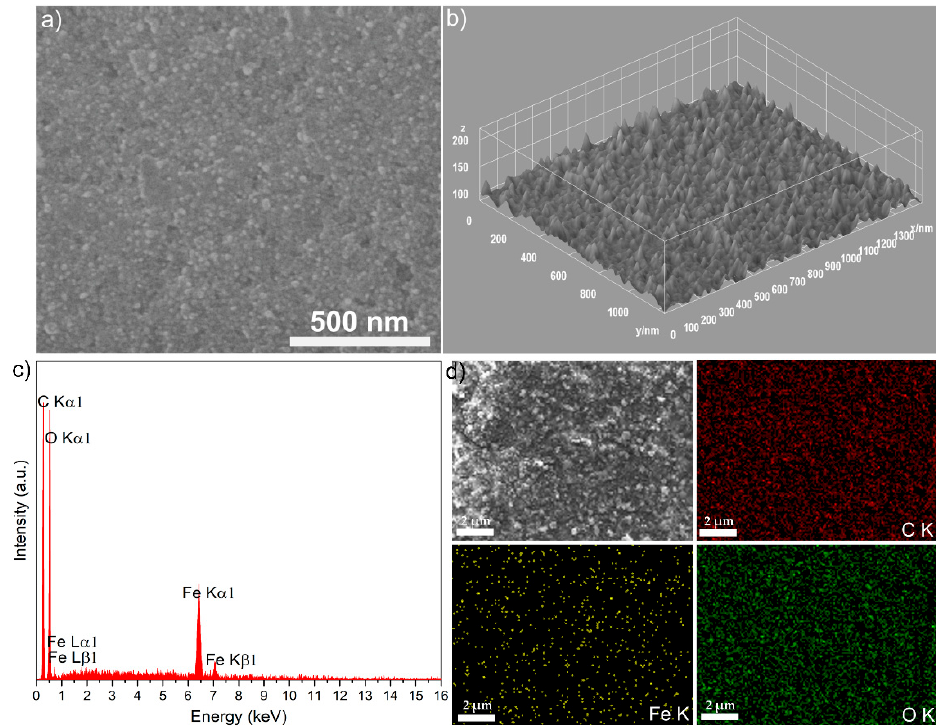
Figure 7. SEM image of surface the D-MNP layer: 2D ( a ), 3D ( b ), and the energy-dispersive X-ray spectroscopy spectra of D-MNP layer ( c ) and the elemental mapping of the D-MNP layer ( d ).